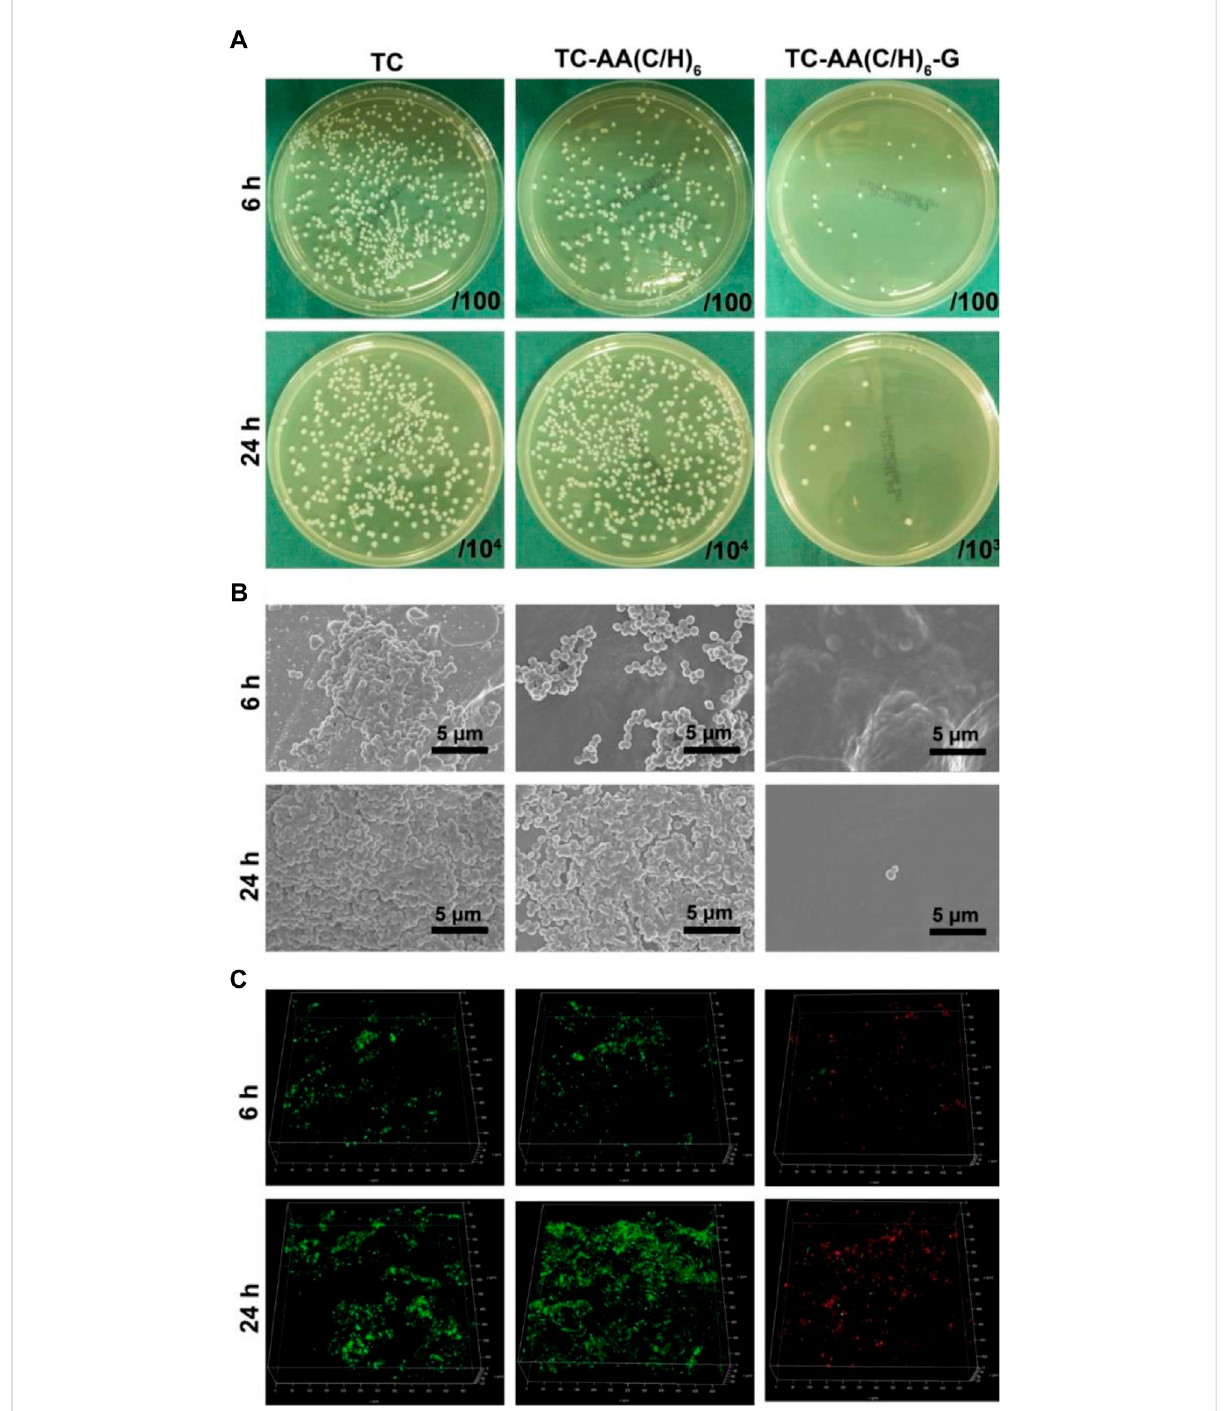
FIGURE 4 Antibacterial properties of TC-AA(C/H) 6 -G. (A) Bacterial colonization and bio fi lm formation by the spread plate method; (B) SEM of bacteria on the three different specimens after incubated 6 h and 24 h; (C) The CLSM views of bacterial colonization and bio fi lm formation on the three kinds of samples, green for living bacteria and red for dead